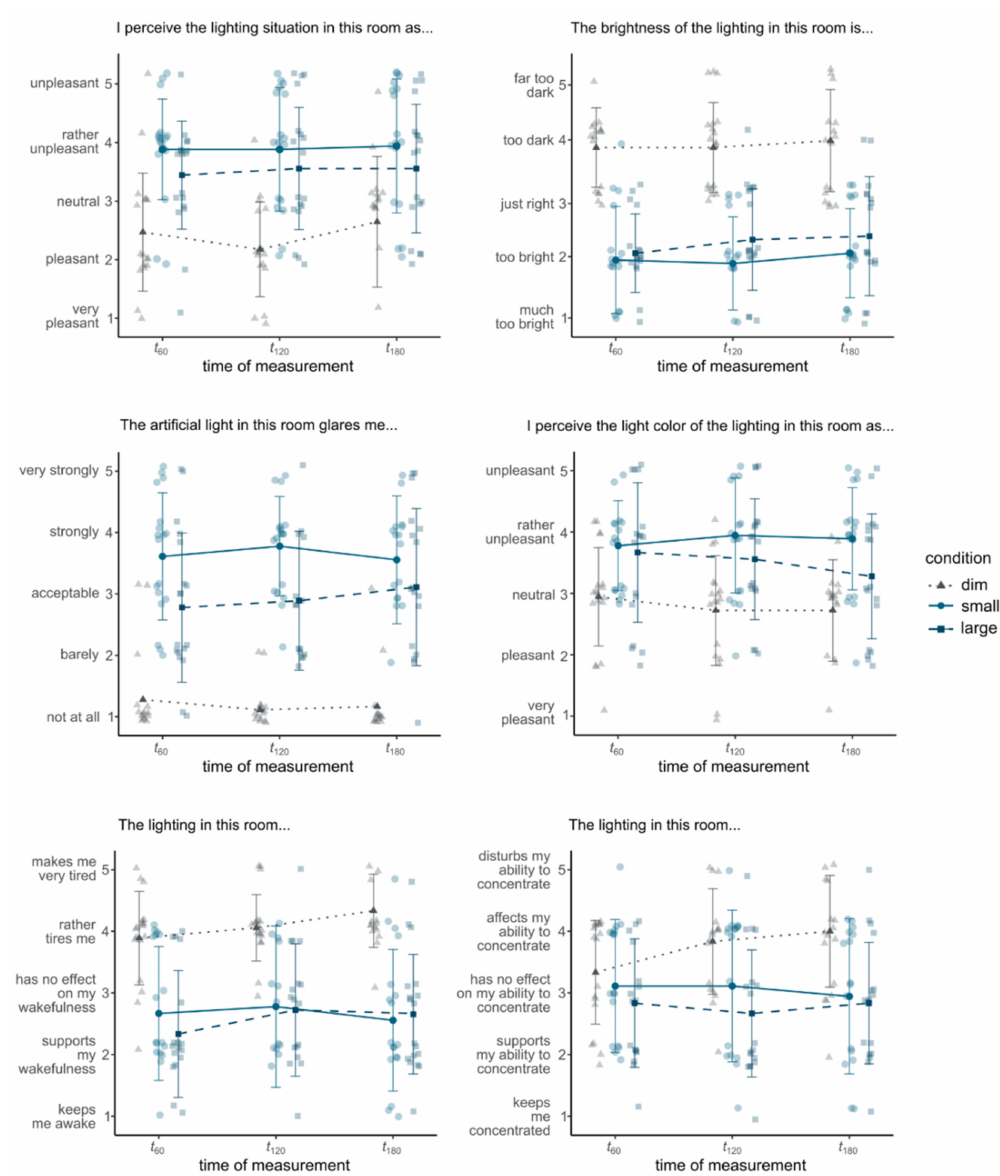
Figure A2. Mean values of the ratings of the six scales of the VCQ. Statistical analysis reveals a significant main effect of condition for lighting situation, F 1.40, 22.38 = 15.08, p < 0.001, η 2 = 0.29, brightness, F 2, 34 = 50.25, p < 0.001, η 2 = 0.54, glaring, F 2, 34 = 62.78, p < 0.001, η 2 = 0.56, light color, F 2, 34 = 10.77, p < 0.001, η 2 = 0.20, effect on wakefulness, F 2, 34 = 20.80, p < 0.001, η 2 = 0.35, and effect on concentration, F 1.44, 24.55 = 4.93, p = 0.02, η 2 = 0.13. The error bars represent the standard deviation. The individual ratings are